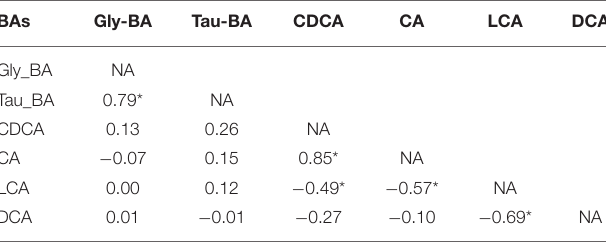
TABLE 1 | Correlation coefficien matrix of dominant bile acids (BAs) and their conjugated form.